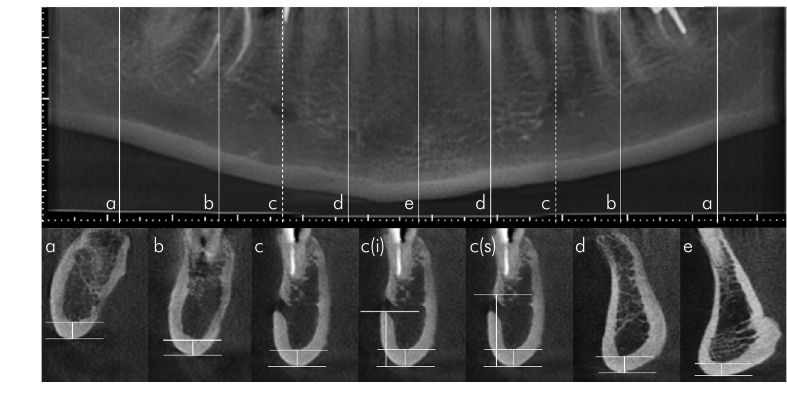
Figure 4. Radiometric indices in cone bean computed tomography. (A) Posterior index (P): thickness in millimeters of the inferior cortex of the mandible 25 mm posterior to the cross-sectional image through the mental foramen. (B) Molar index (M): thickness in millimeters of the inferior cortex of the mandible 10 mm posterior to the cross-sectional image through the mental foramen. (C) Computed tomography mandibular index (CTMI): inferior cortical width of the mandible. (C I) . Computed tomography index (inferior) [CTI (I)]: ratio of the inferior cortical width to the distance from the inferior margin of the mental foramen to the inferior border of